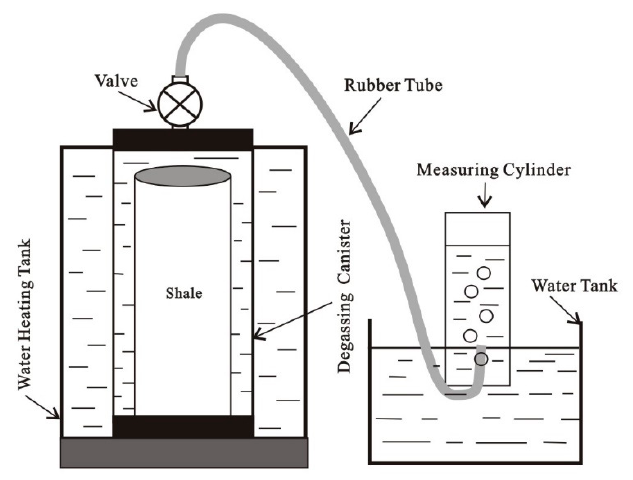
Figure 1. Composition of water heating degassing instrument.